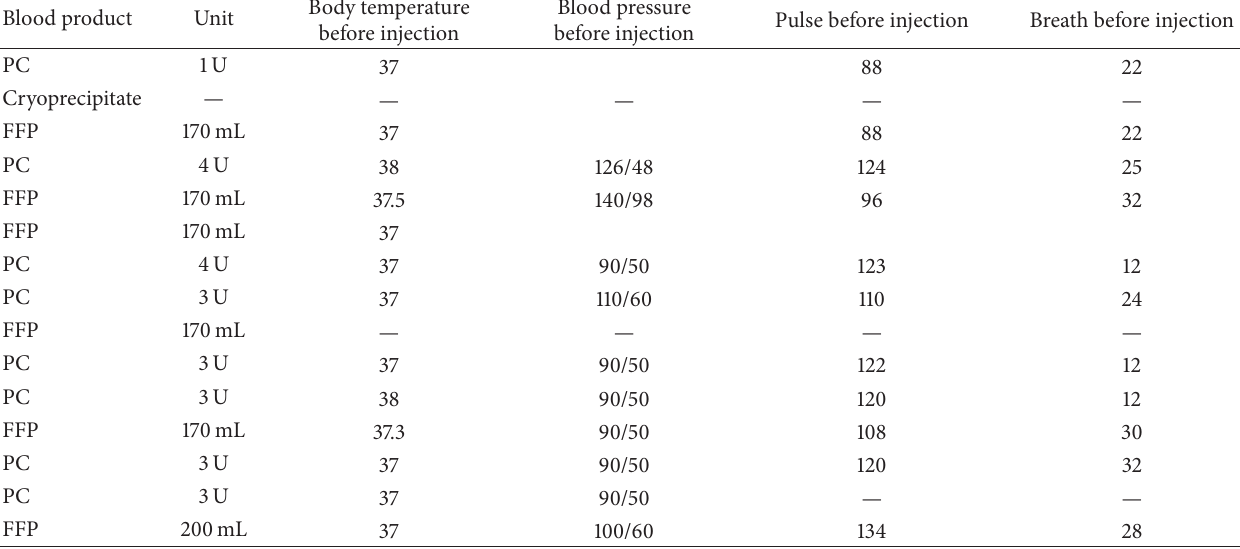
Table 2: Different blood product injection and vital sings during 3 days of bleeding.